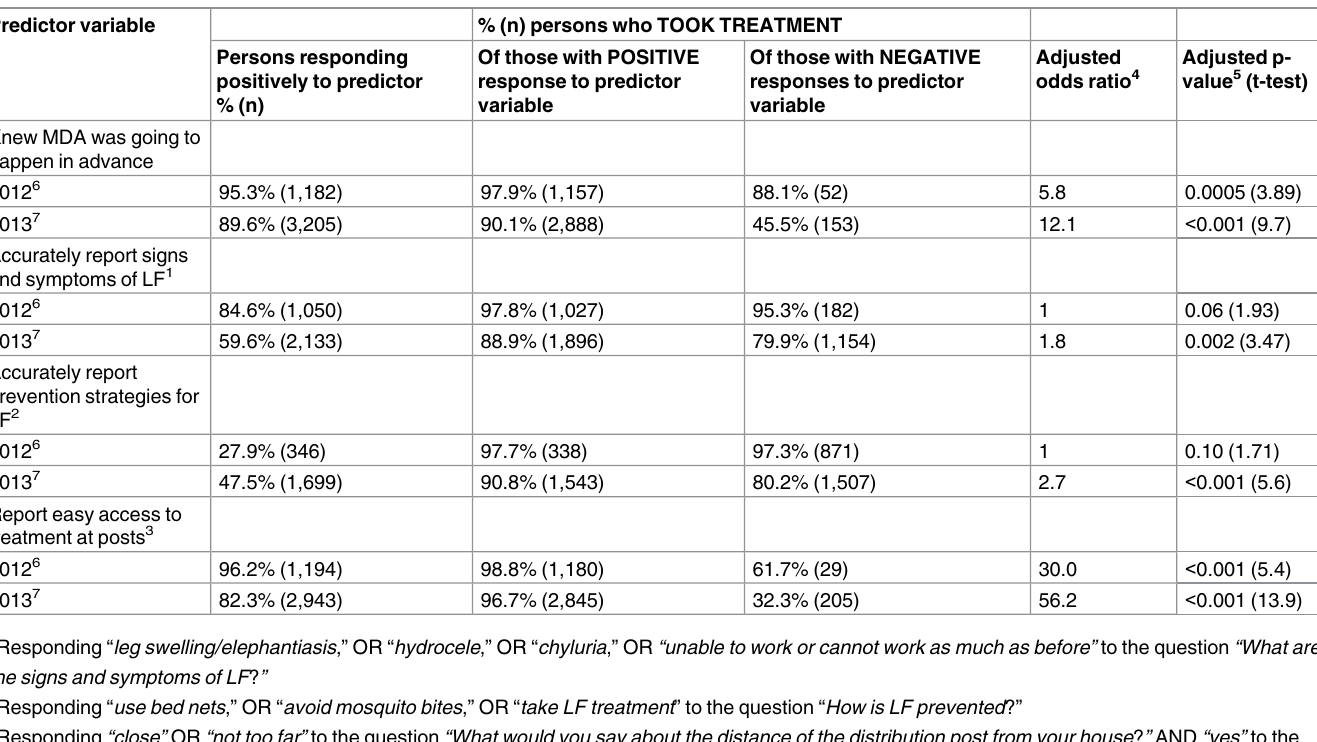
Table 3. Variables associated with treatment